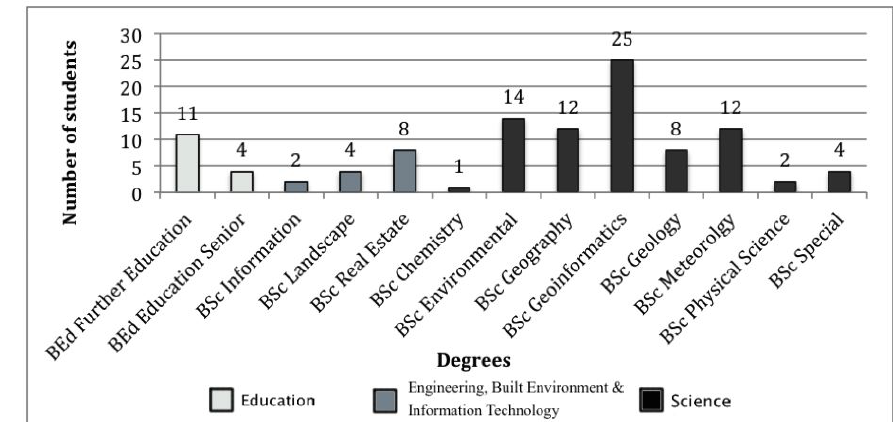
Figure 3. Degree programs participants are enrolled in.